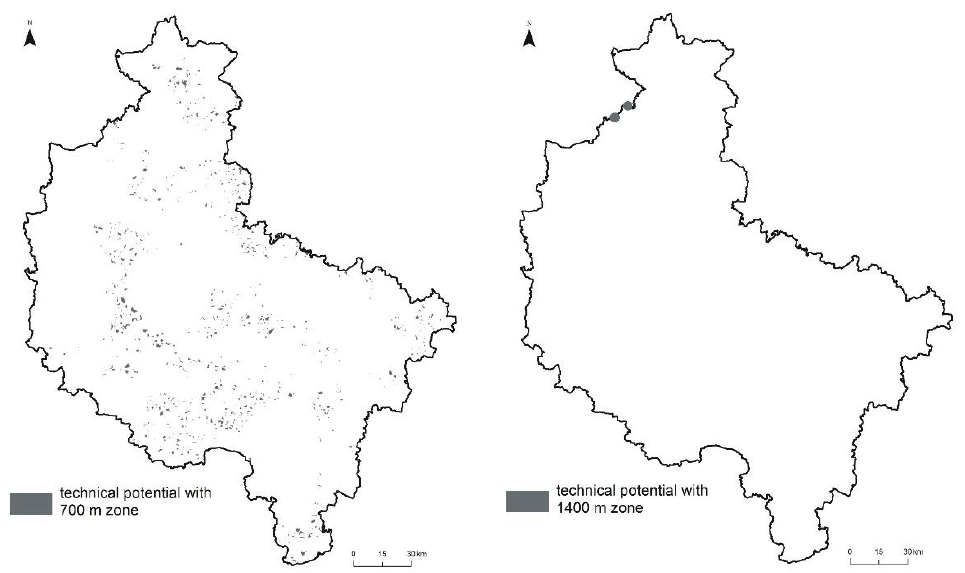
Figure 8. Area available for wind energy development with the buffer zone of 700 m and 1400 m in the Greater Poland Voivodeship (own calculations).